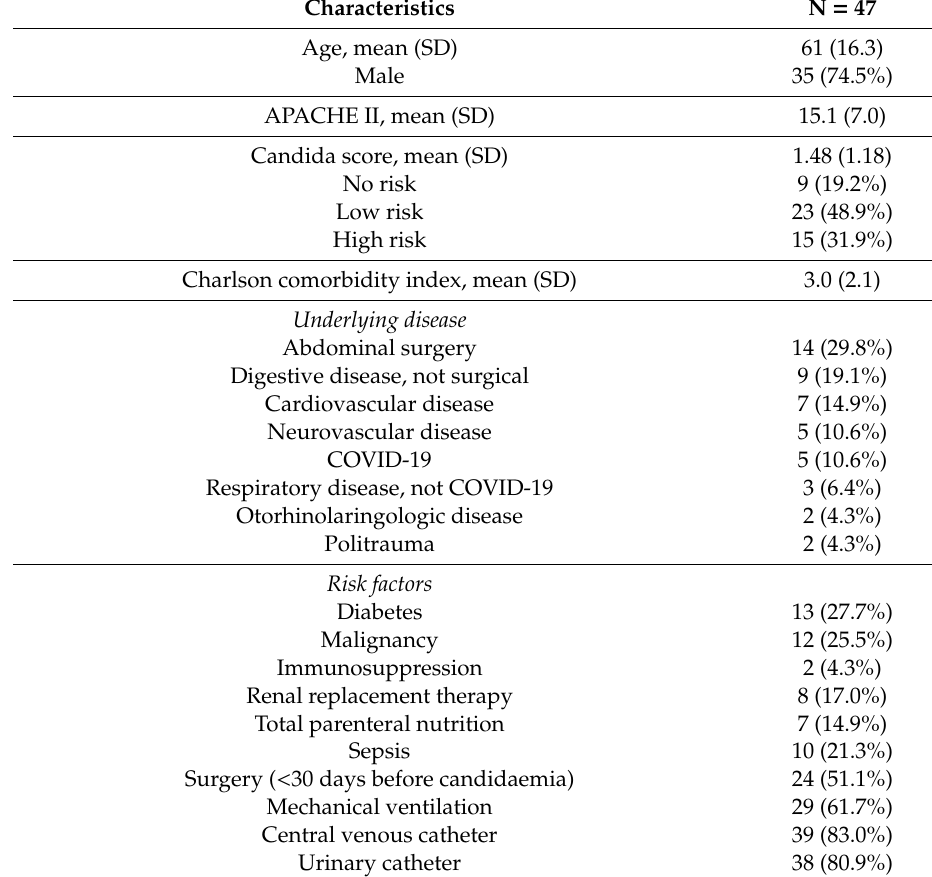
Epidemiological and clinical characteristics, antifungal treatment and outcome of C. auris